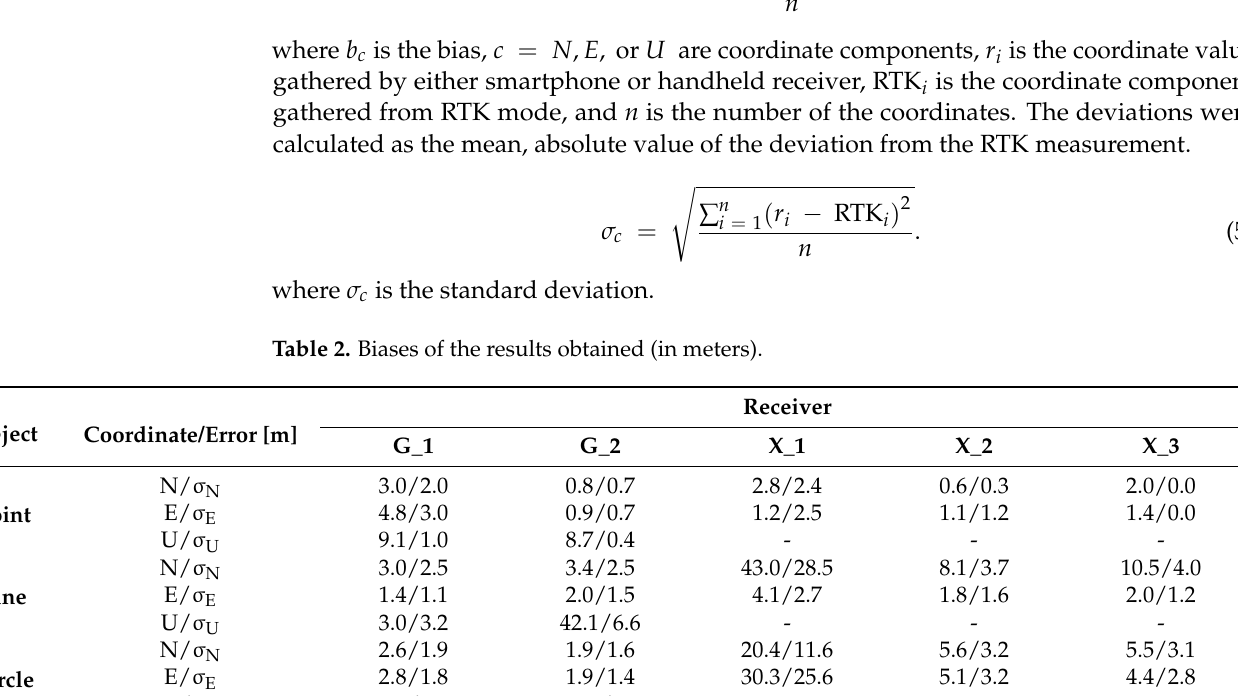
Figure 13. Plot of U-component deviations of surface measurements with code receivers.